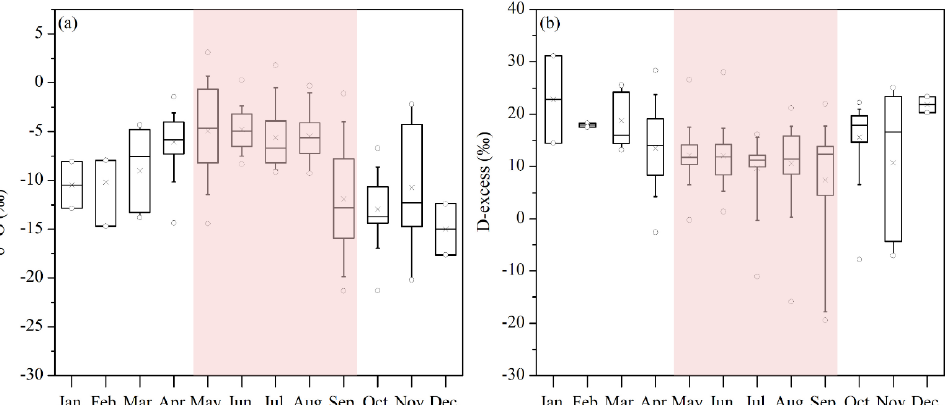
Figure 3. Box line plots of δ 18 O ( a ) and d-excess ( b ) in event precipitation for the 12 months from April 2019 to October 2021, where the shaded area is the summer half; the top and bottom of the box are the 25th and 75th percentiles, the whiskers are maxima and minima, the line near the middle of the box is the median, the cross is the mean, and the hollow circles are the outliers.